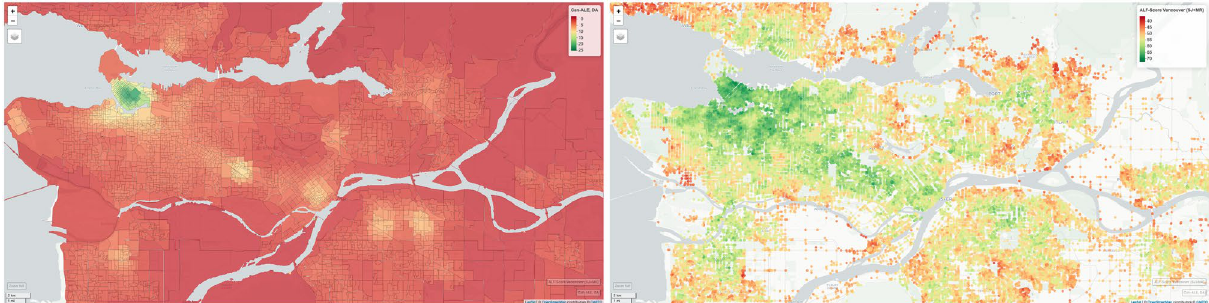
Figure 8. Left: Can-ALE for the city of Vancouver, BC. Right: walkability results produced by ALF-Score++ for the city of Vancouver, BC using the zero-user-input approach of a model trained through transfer learning based on user data from two cities of St. John’s and Montréal. The road network for Vancouver maintains over 45 thousand nodes. (Maps generated through RStudio 44 Version 1.2 using mapview package from Additionally, ALF-Score captured a cluster of greener/more walkable spots close to student’s housing and living quarters near Queen’s University. While this area is popular among many students, faculty and other members of the public, Can-ALE was unable to capture it due to its area-based structure and lower spatial resolution. Moreover, we observed various other areas that ALF-Score++ ranked as walkable whereas Can-ALE failed to capture their actual walkability due to it’s lower resolution and granularity. For instance, the Division St.—Dalton Ave.—Benson St. region (which falls under multiple DAs) is ranked with low walkability scores by Can-ALE whereas ALF-Score captured and distributed much more refined and relatable walkability scores to varying spots where there are many restaurants, stores and other popular places. Furthermore, the walkability of Point Frederick Peninsula (across the LaSalle Causeway bridge) is in the red zone of Can-ALE’s scores while ALF-Score suggests the opposite for the region. This region houses multiple military campuses with varying facilities and is deemed walkable. Figure 8 shows the ALF-Score++ walkability (right) compared to Can-ALE scores (left) for the city of Van- couver, BC. The ALF-Score++ for this region is generated based on a zero-user-input approach and similar to ALF-Score++ for Kingston, we can observe high spatial resolution as opposed to Can-ALE’s low spatial resolution for the same area. To look further into this region, we can start by observing the University of British Columbia campus where Can-ALE highlights the inner campus area (left side) with light orange while the outer campus area (right side) remains darker orange. ALF-Score++ picks up on the fact that the right area should be more walkable due to bus stops and various facilities commonly used by students and staff. Additionally, North Van- couver’s walkability appears not to have been captured by Can-ALE where its walkability for the region is ranging between dark orange and red. In contrast, ALF-Score better captures various popular areas in North Vancouver that are walkable. Furthermore, the walkability for the Richmond area is barely captured by Can-ALE with mostly dark orange and red walkability. ALF-Score++ on the other hand is able to capture various walkable areas in that region. An interesting observation here is the similarity with zero-user-input walkability data generated for the city of Kingston. Can-ALE typically marks areas close to water as less walkable whereas ALF-Score++ tends to object. ALF-Score++’s results are positively associated to our collective knowledge of Vancouver and Kingston. We can observe that ALF-Score++ is utilizing its transferability capabilities to better understand the city structures and find patterns in various associated data to generate zero-user-input walkability scores for virtually any location on the road. As observed earlier, the combination of user data from just two cities of St. John’s and Montréal allowed us to generate accurate walkability scores for cities never seen by our algorithms. It is our observation that transfer learning works well in this application even with a small set of user data. Additionally, we believe as we accu- mulate more user data, our algorithms will be able to better capture various patterns in the data leading to an improved accuracy. In this research, we were also able to show ALF-Score++’s pipeline is scalable as data size increases. The pipe- line was optimized to perform well while processing, training and predicting walkability scores for small and large cities alike. One of the major enhancements to the pipeline was improving the GLEPO algorithm such that Intel Core i7 (Turbo Boost up to 3.2 GHz) with 4 MB shared L3 cache and 8 GB of 1600 MHz LPDDR3 on-board memory. Over a typical run of the algorithm, we went through approximately 50 iterations totaling to over 14 h